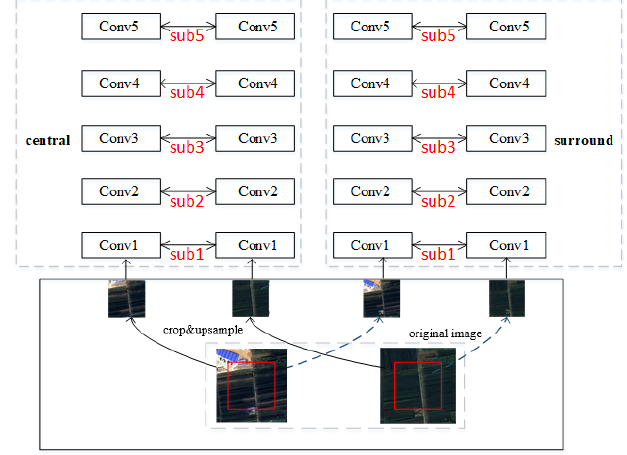
Figure 8. Center-surround architecture. Conv1-5 is the generator encoder shared weight.